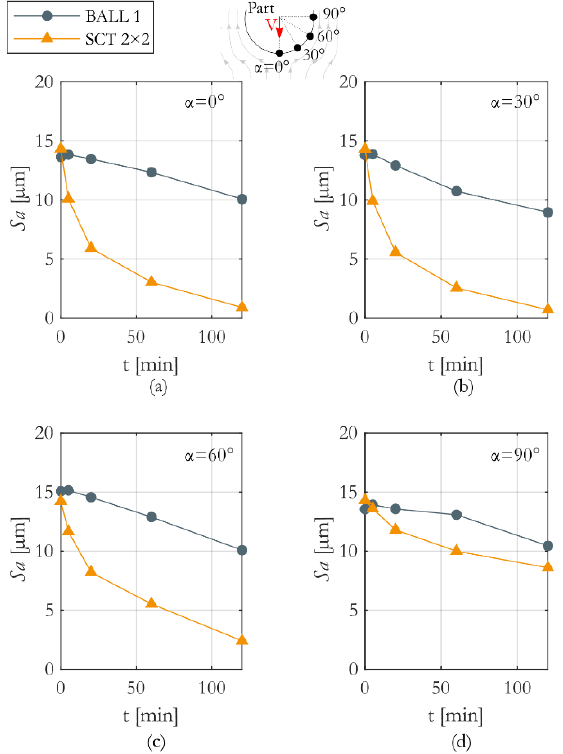
Figure 3. Drag finishing experimental results: Sa evolution according to the orientation angle ( α ) ( a – d ) of the surface and the abrasive media (BALL 1 and SCT 2 ×